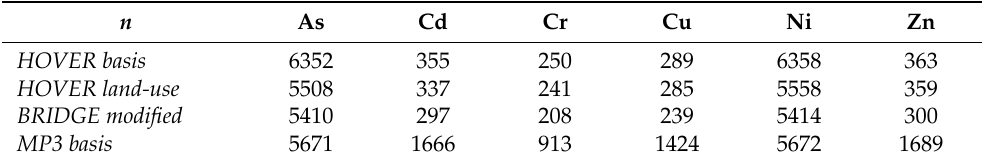
Table 3. Groundwater sampling points in the datasets after excluding the anthropogenically influ- enced points.